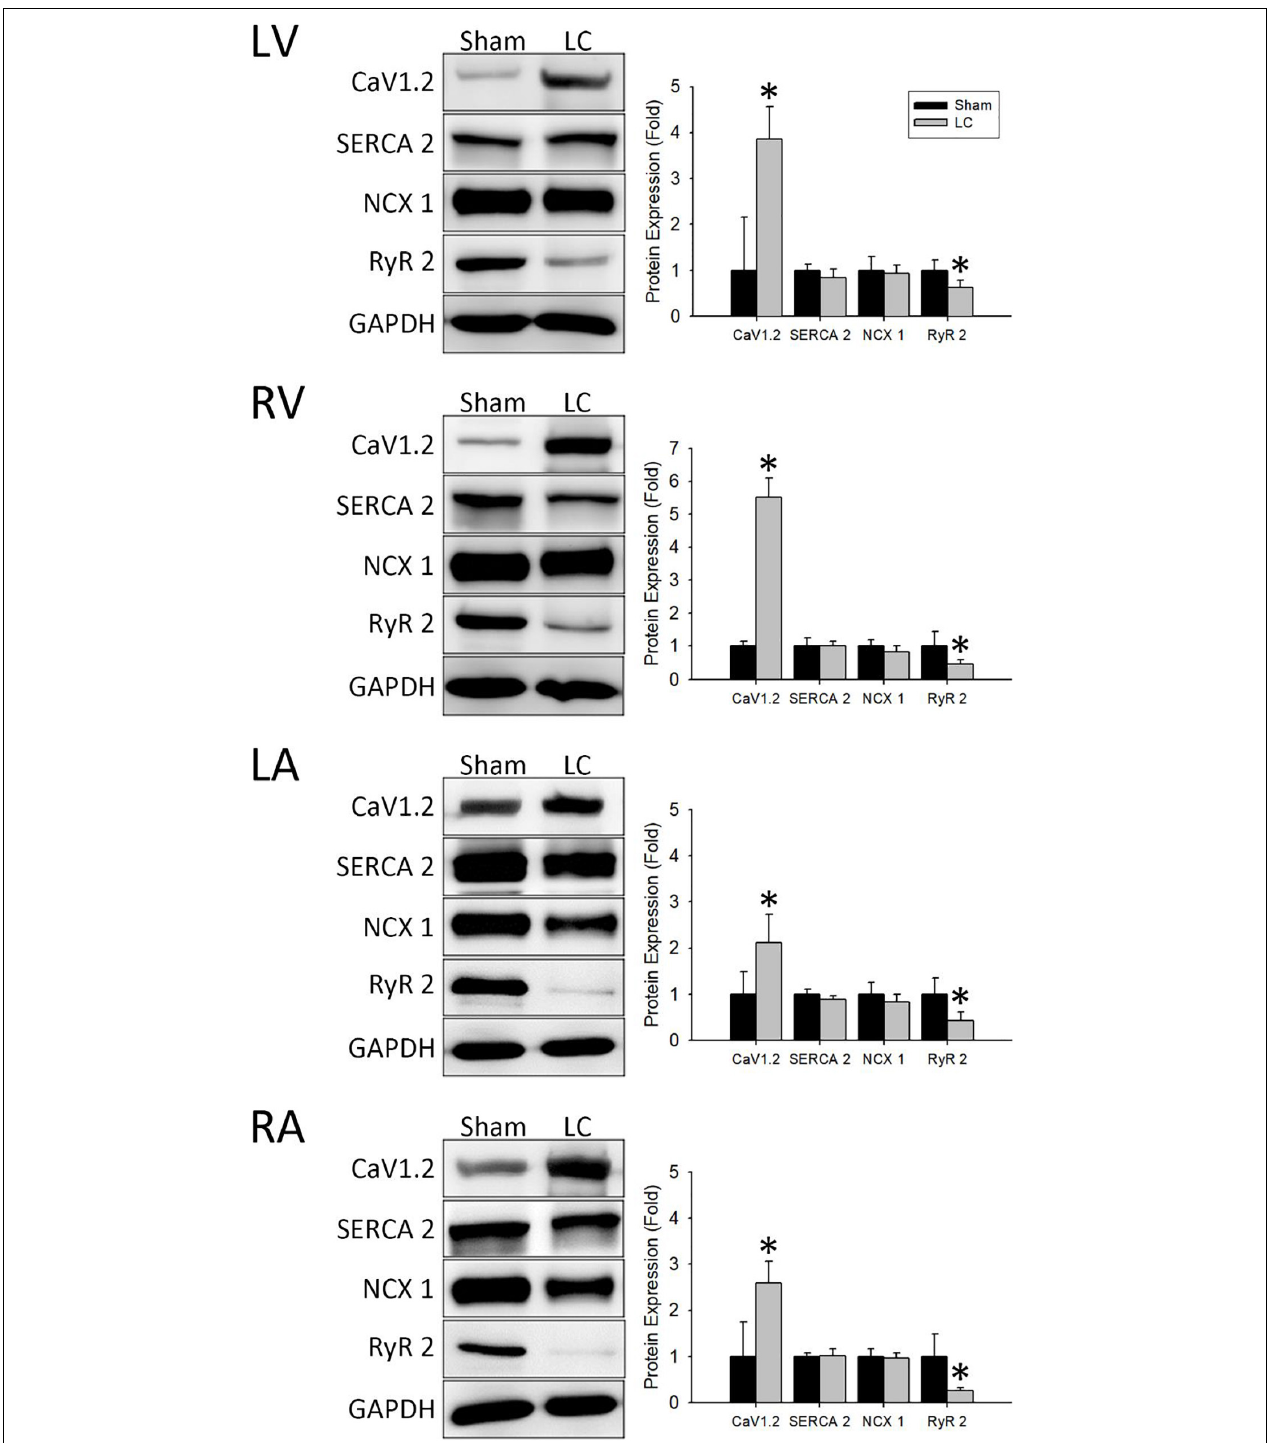
FIGURE 5 | Western blot analyses for protein expressions of the myocardium. (Left) Representative Western blot images of ion channel protein expressions from the left ventricle (LV), right ventricle (RV), left atrium (LA), and right atrium (RA). (Right) The ionic channel protein level of CaV1.2 in the LC group was significantly higher than in the sham group in all cardiac chambers. The ionic channel protein level of SERCA 2 and NCX 1 showed no difference between the two groups in all cardiac chambers. The ionic channel protein level of RyR 2 in the LC group was significantly lower than the sham group in all cardiac chambers. ∗ p < 0.01 compared with the sham group. CaV1.2, voltage-gated L-type Ca 2 + channel; GAPDH, glyceraldehyde-3-phosphate dehydrogenase; NCX 1, Na + /Ca 2 + -exchanger type 1; RyR 2, ryanodine receptor 2; SERCA 2, sarcoplasmic reticulum Ca 2 + -ATPase 2.